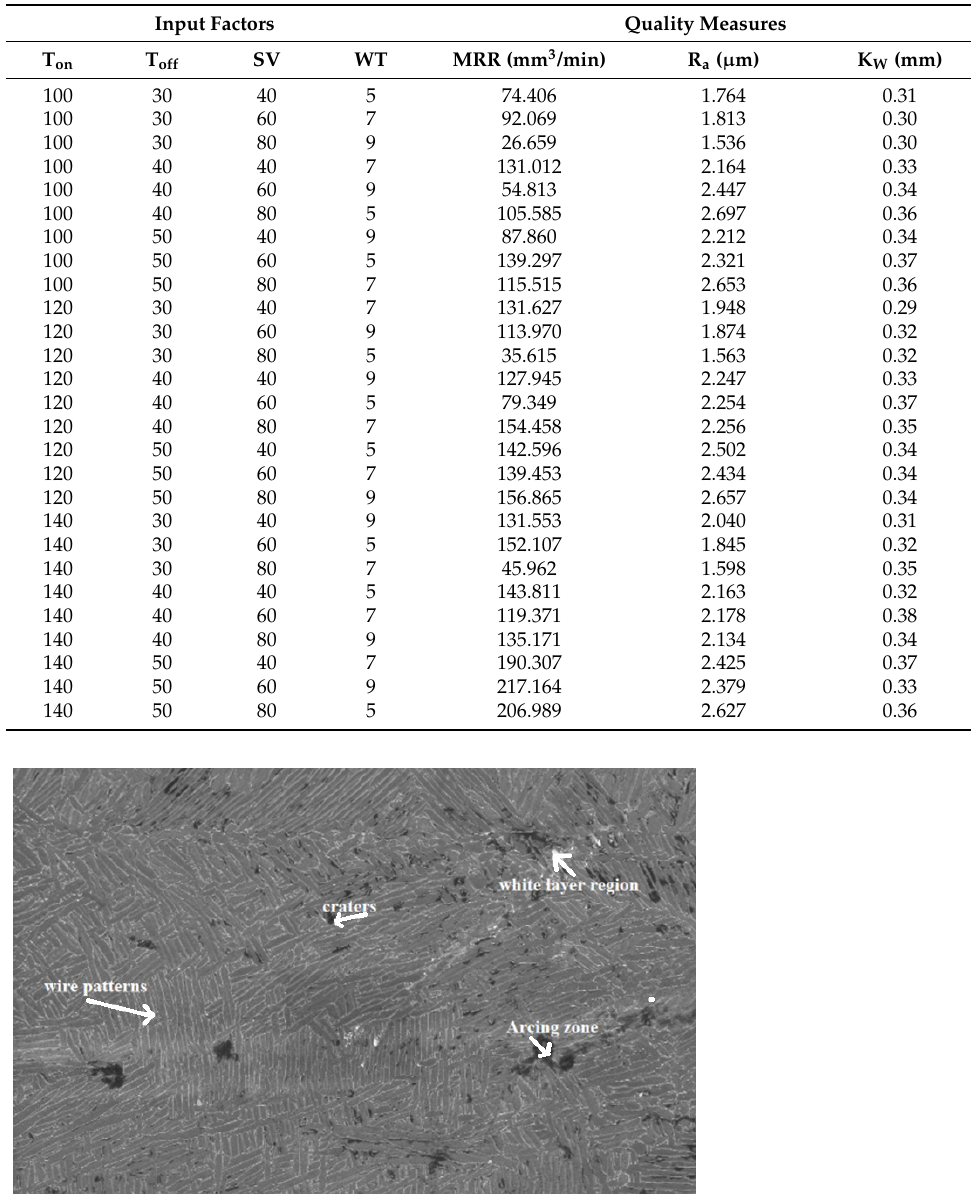
Table 4. Calculation of performance measures in the WEDM.